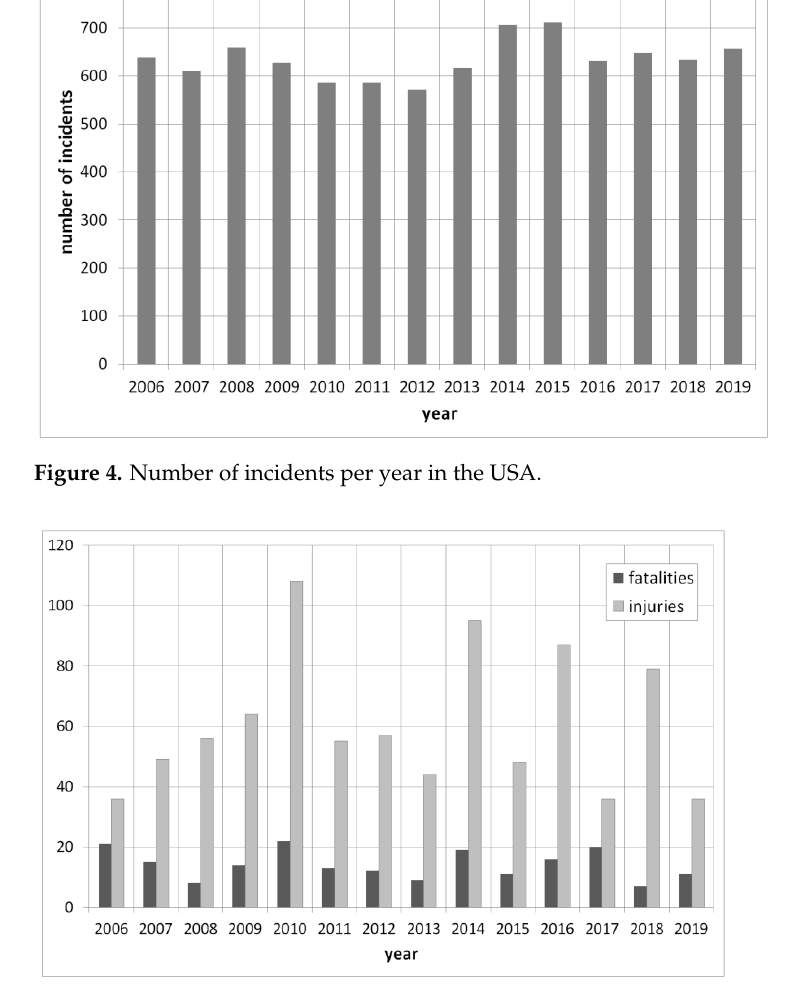
Figure 5. Number of fatalities and injuries per year in the USA.